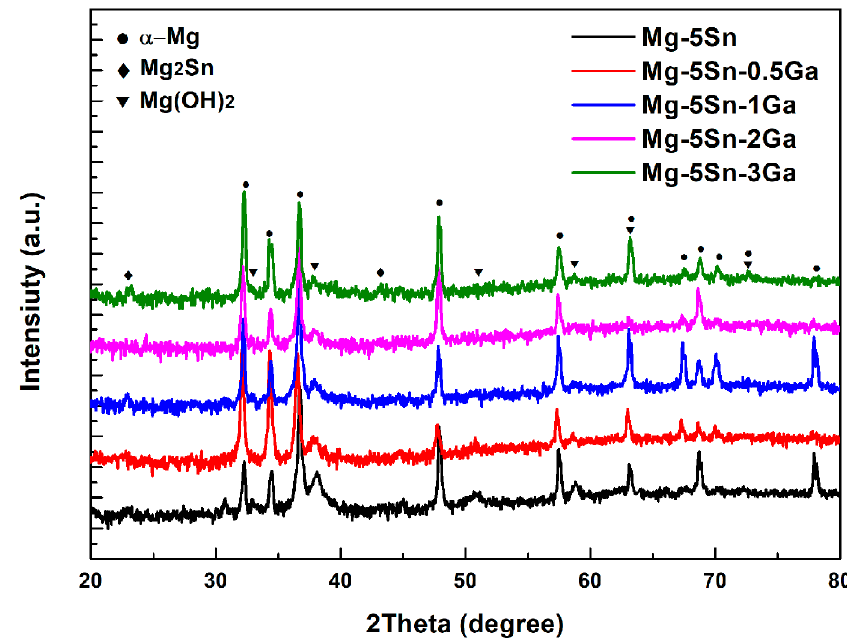
Figure 9. XRD patterns of the Mg–5Sn– x Ga alloys after immersion in 3.5 wt % NaCl solution for 24 h.